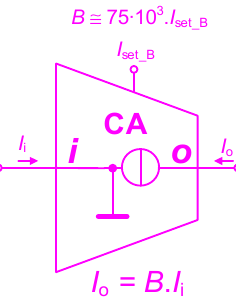
Figure 5. Schematic symbol and description of the ideal interterminal transfer relations of the adjustable current amplifier (CA).